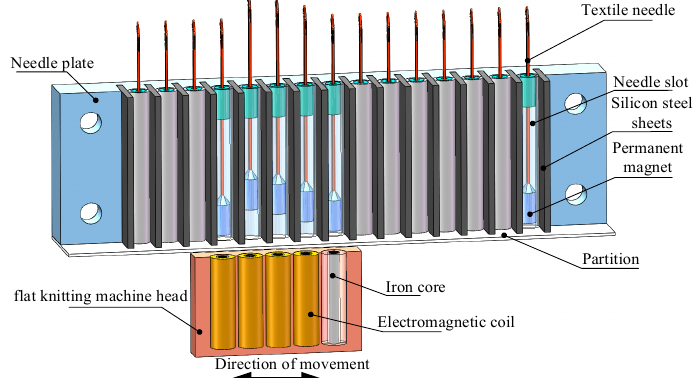
Figure 1. Driving structure diagram of hybrid maglev needle array.